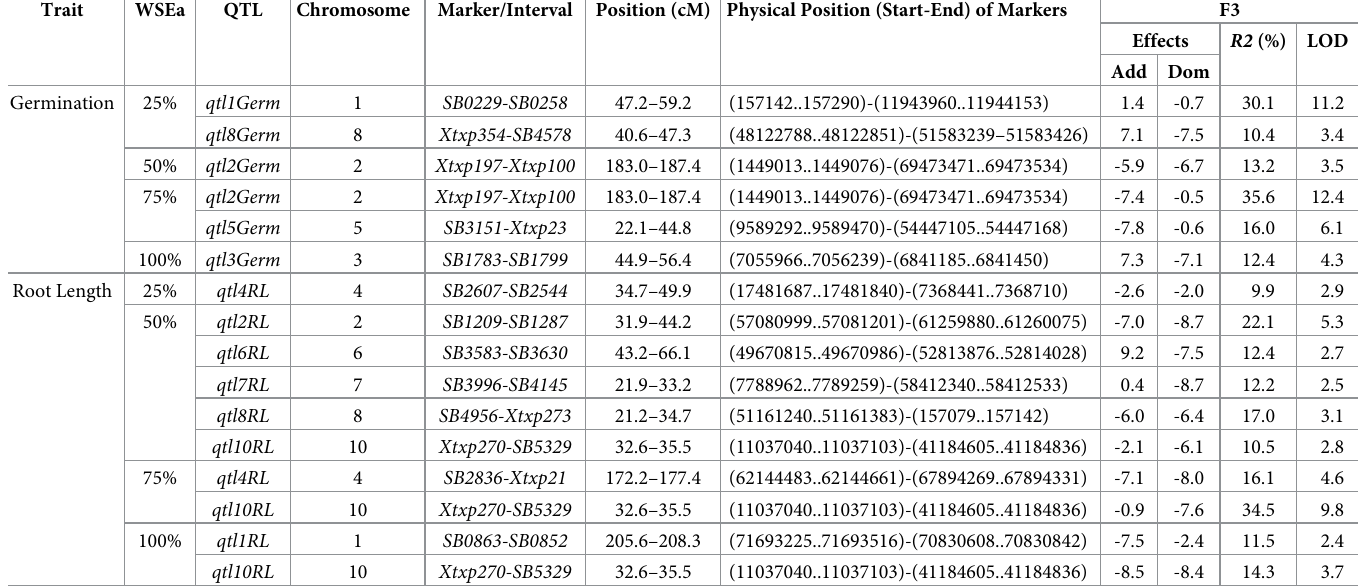
Table 3. QTLs identified by linkage analysis using composite interval mapping (CIM) model for the effects of WSE from 134 F3 lines on germination and root length growth of lettuce plant. Trait